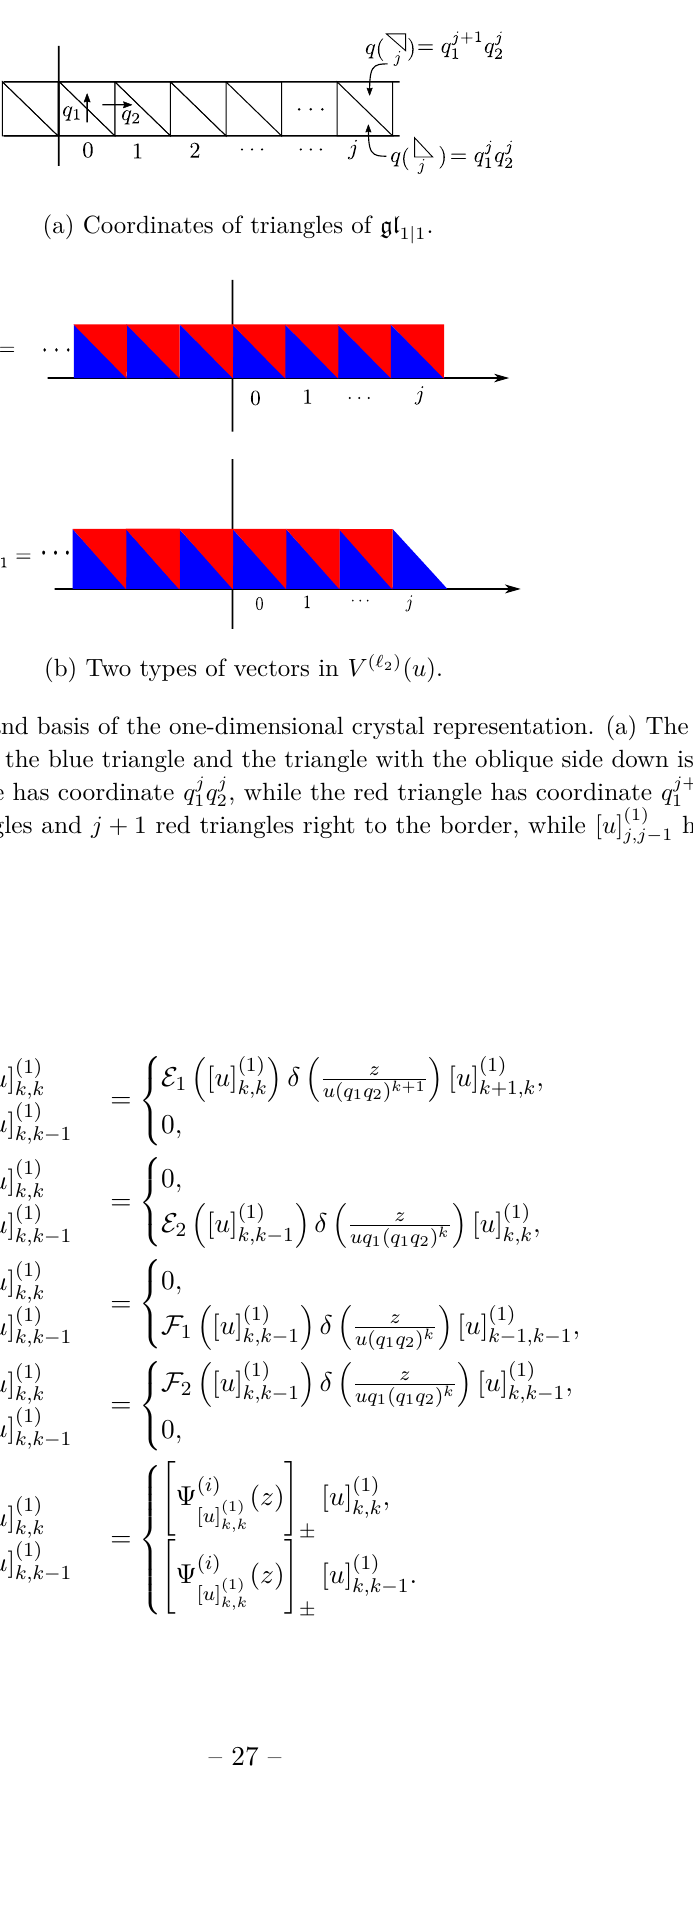
(a) Coordinates of triangles of gl